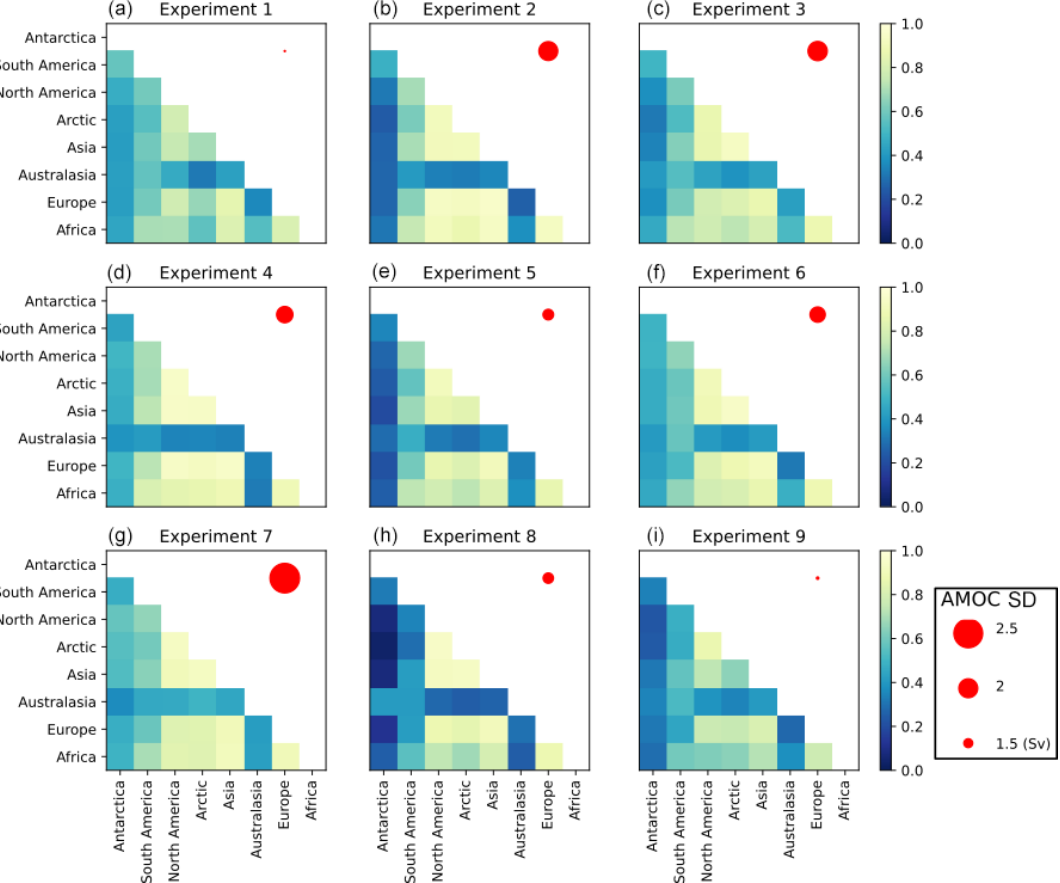
Clim. Past, 18, 2523–2544, 2022